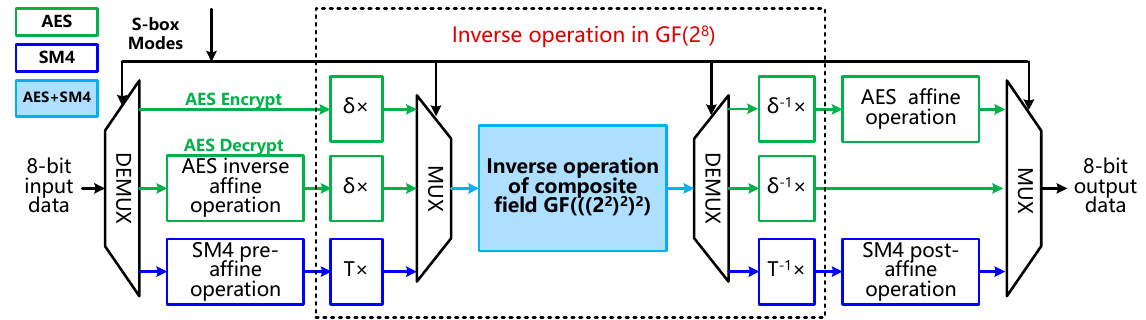
Figure 6. The reconfigurable S-Box module for AES and SM4.